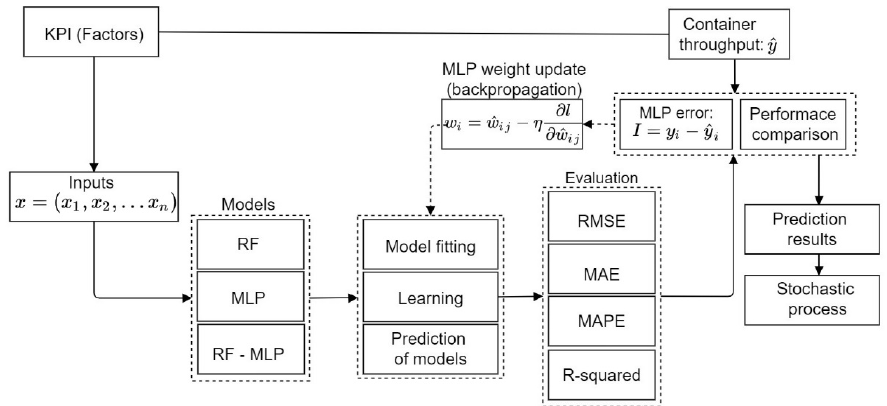
Figure 4. Conceptual framework of the entire study (Source: author).